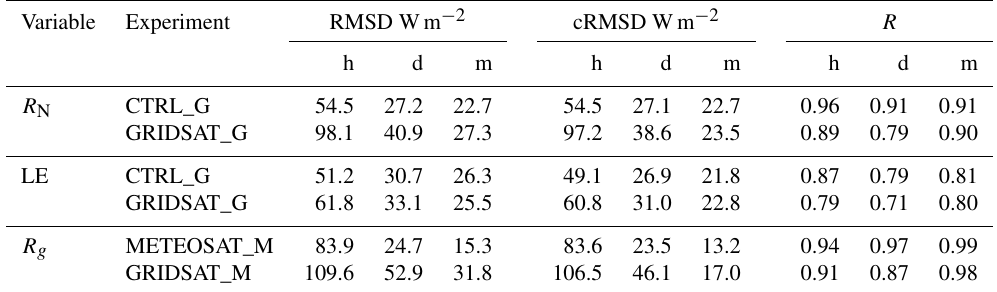
Table 3. Overall HOLAPS accuracies for R N , LE and R g , at hourly (h), daily (d) and monthly (m) timescales for the CTRL, GRIDSAT and METEOSAT